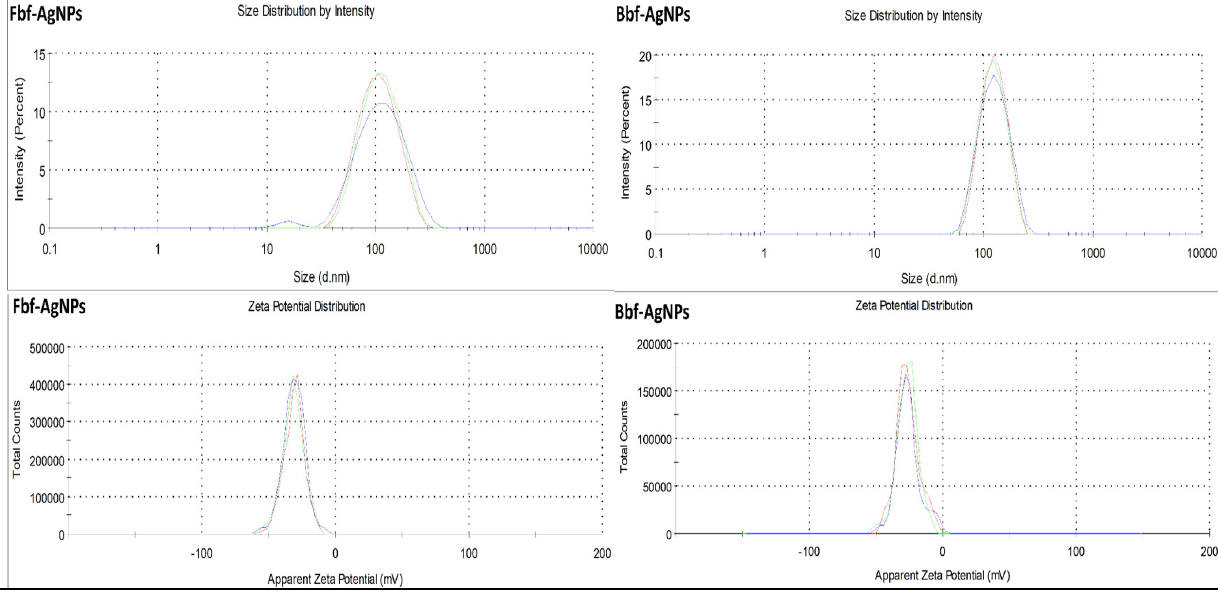
α -glucosidase inhibition, and